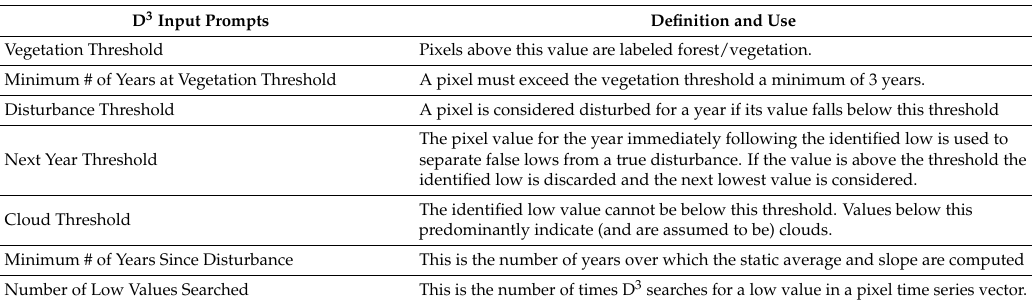
Table A1. User-Specified Parameters.